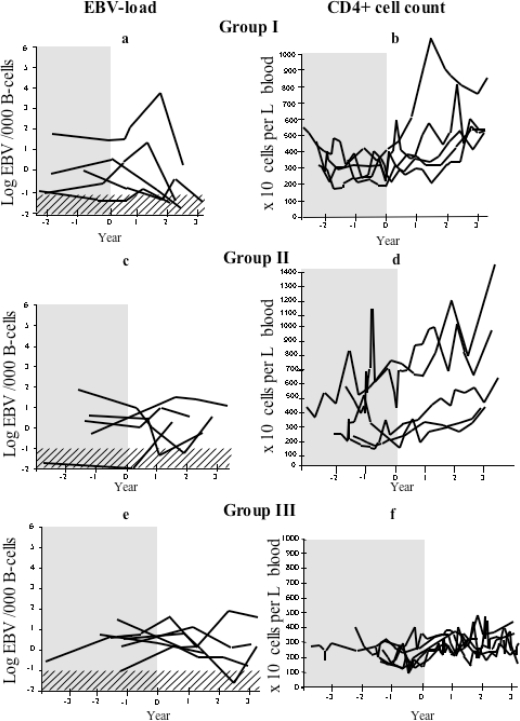
The effect of cART treatment on CD4 counts and EBV load over time. Upper limit of EBV load in healthy controls is stipled and time before cART is shadowed. (a) EBV load in group I (with constant undetectable HIV-values after introduction of cART) and (b) CD4 levels in group I. (c) EBV load in group II (with most but not all HIV-values below detection limit after introduction of cART) and (d) CD4 levels in group II. (e) EBV load group III (with most HIV-RNA values above detection limit after introduction of cART) and (f) CD4 levels group III.